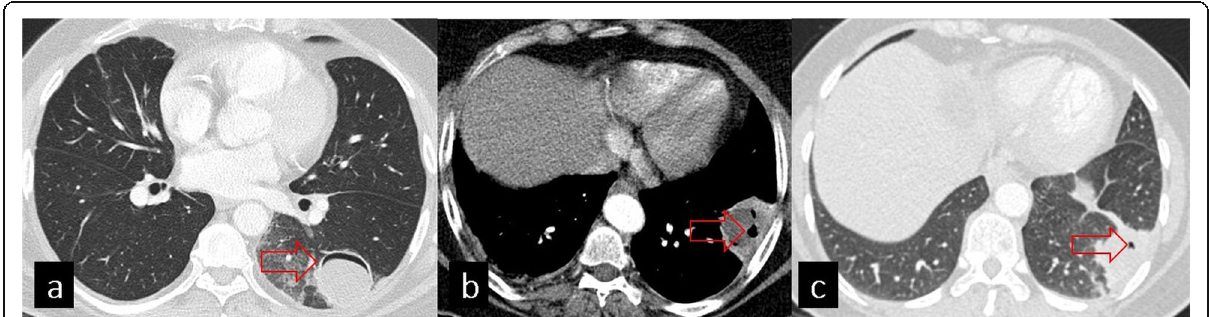
Fig. 5 Imaging features of contained rupture. Axial CT images show the crescent sign ( a , red arrow), inverse crescent sign ( b , red arrow), and air bubble sign ( c , red arrow)